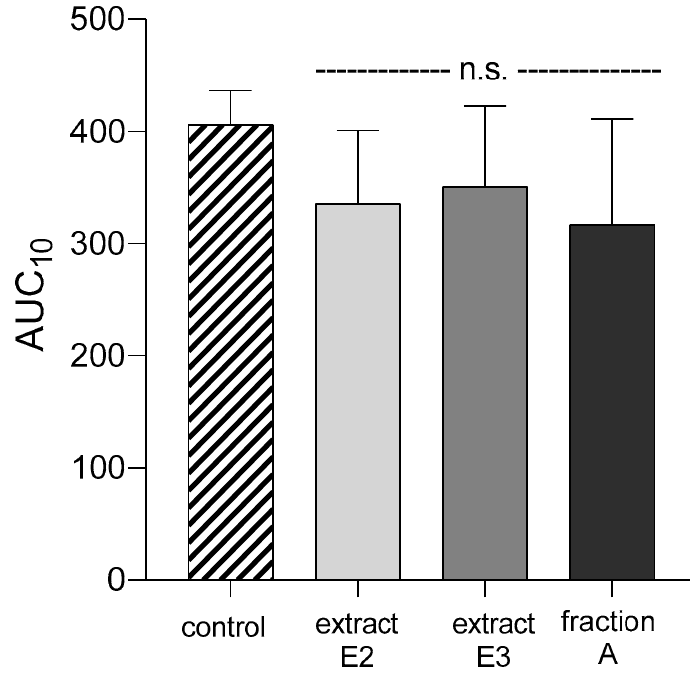
Figure 12. Effects of dandelion fruit preparations (E2, E3, and fraction A; concentration 50 µg/mL) on the T-TAS using the PL-chip in whole blood samples. Whole blood samples were analyzed by the T-TAS at the shear rates of 1000 s − 1 on the PL-chips. The area under the curve (AUC 10 ) in PL are shown as closed circles. Data represent the means ± SE of six healthy volunteers; n.s. p > 0.05, compared with control. Table 4. Effects of extracts (E1–E3) and flavonoid fractions (A–D) of dandelion fruits (concentrations 10 and 50 µg/mL) on the coagulation times of human plasma (APTT, PT, and TT). Data are presented as means ± SD ( n = 10).